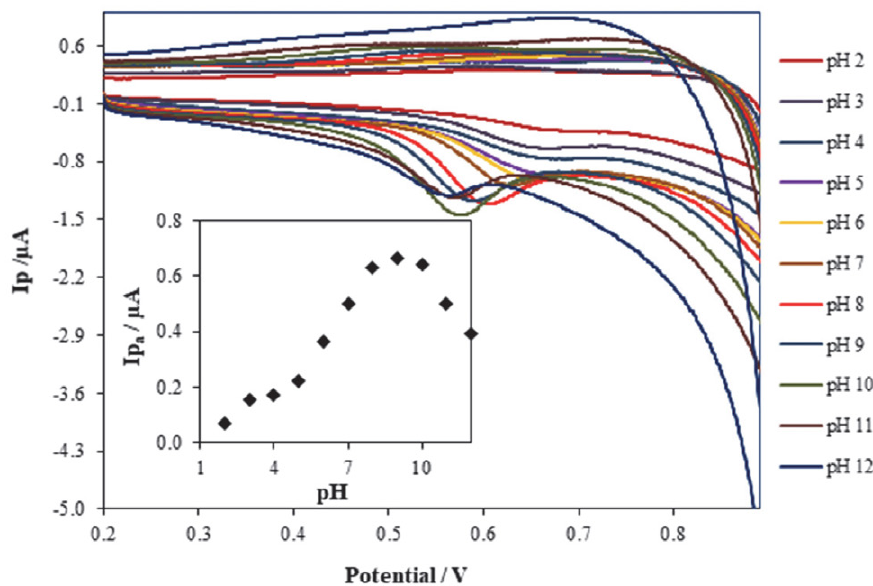
Figure 6. CVs of 1.0 µM KC in different pH values Inset: pH-i p